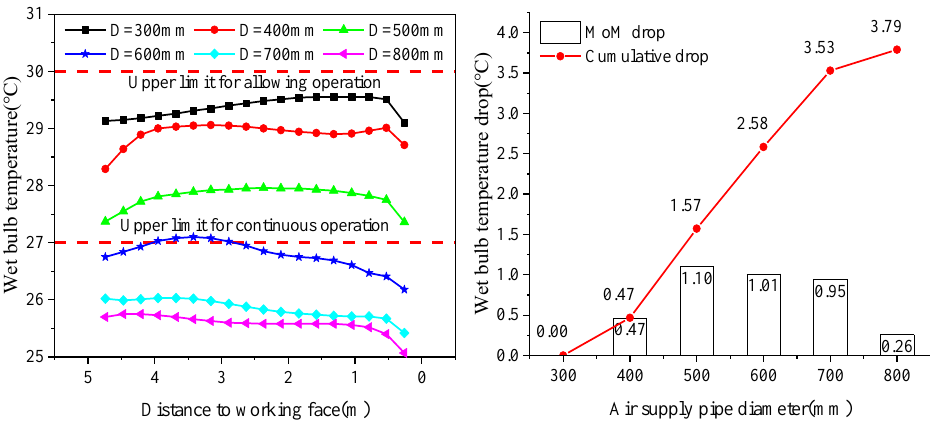
Figure 9. Wet bulb temperature distribution of drift centerline under different air supply pipe.